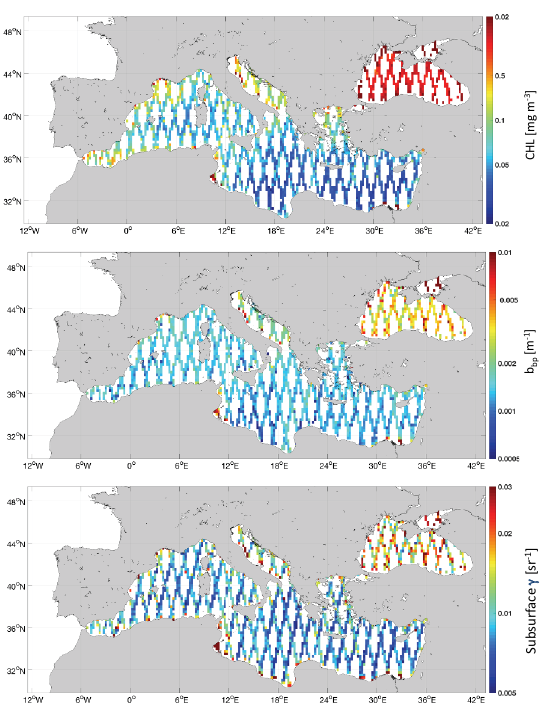
Fig.1 Distribution of Chl-a , b CALIOP groundtracks (high, middle and low panels, respectively) obtained from CMEMS computation and from eq. (3), respectively.